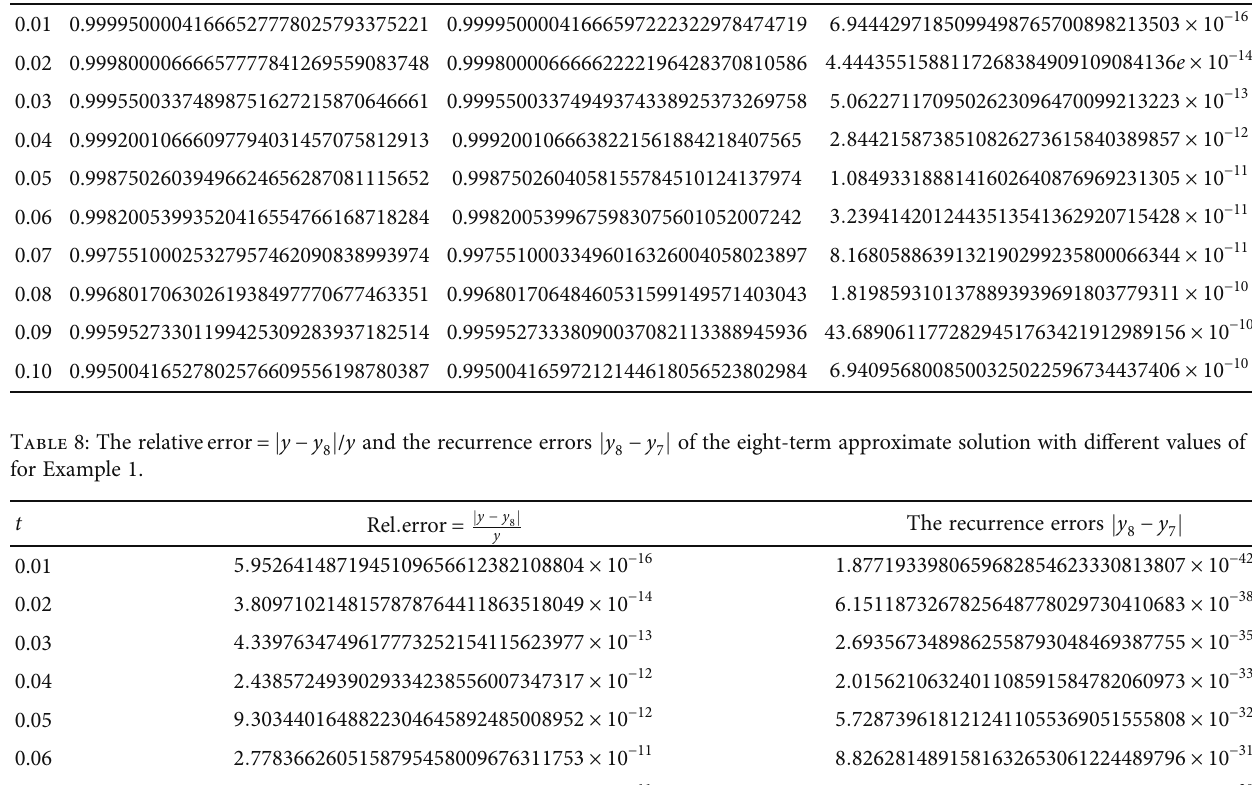
Table 7: Eight-term approximate solution by SIM and comparison with the exact solution of Example 5 for di ff erent values of time variable t and the absolute error E = j y 8 − exact j .